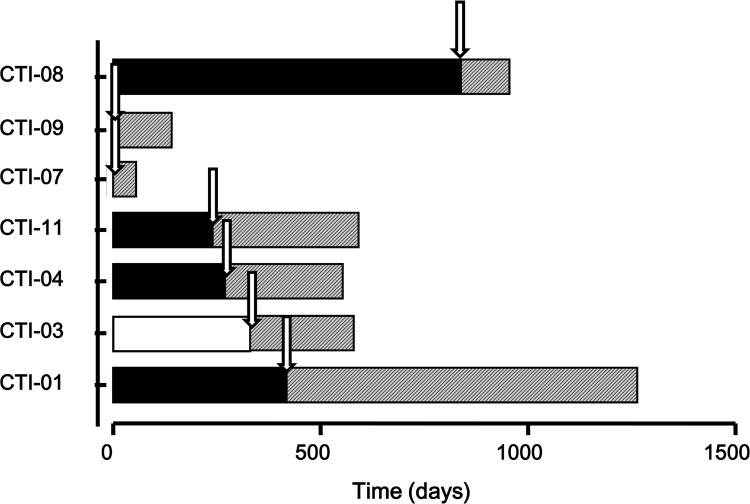
Clinical outcome.Duration of most recent previous CR (black blocks) or PR (white block) prior to ATIMP administration (white arrow) is shown relative to the duration of CR post IMP infusion (gray blocks). Patients 01, 03, 04 and 11 all experienced a longer duration of remission post IMP infusion than their previous CR which was not seen in the other patients.